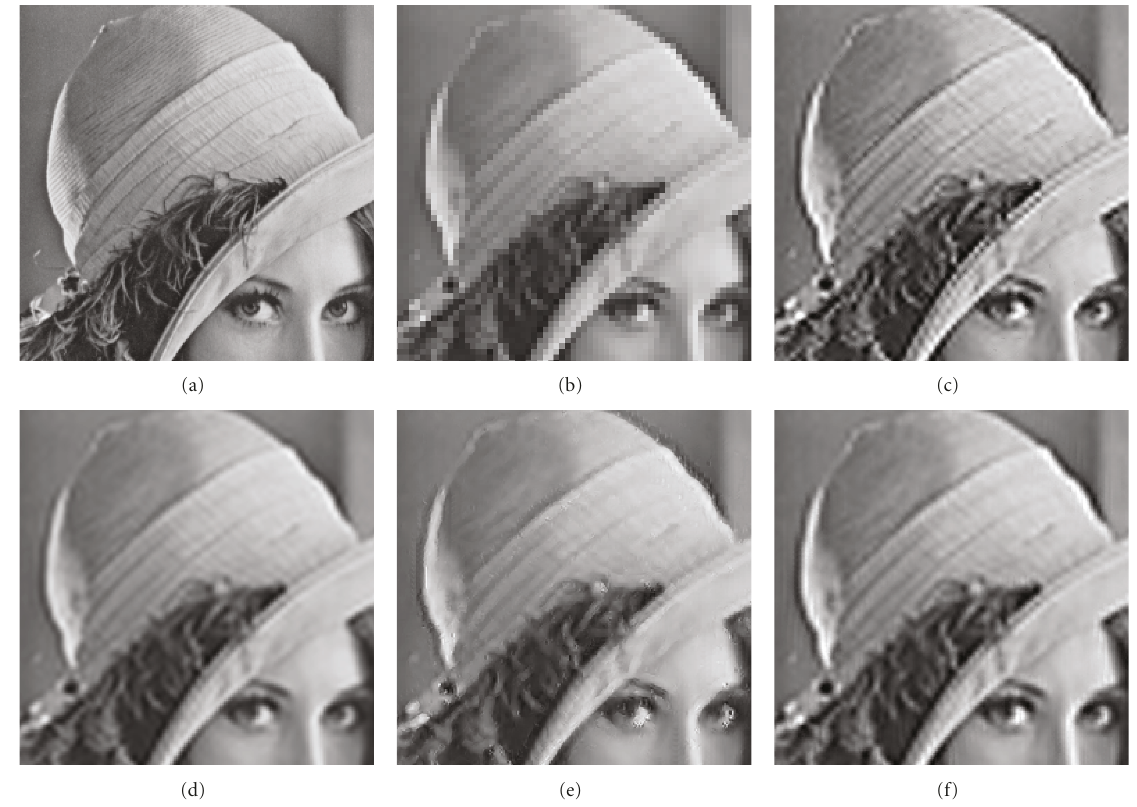
Figure 4: Zoomed portions of the results in Figure 3: (a) zoomed portion of Figure 3(a), (b) zoomed portion of Figure 3(b), (c) zoomed portion of Figure 3(c), (d) zoomed portion of Figure 3(d), (e) zoomed portion of Figure 3(e), and (f) zoomed portion of Figure